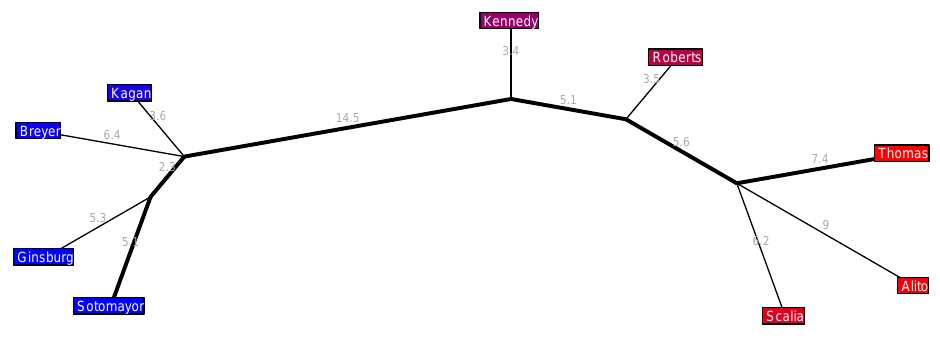
Figure 6. Judicial tree for the 2010–2016 Roberts 4